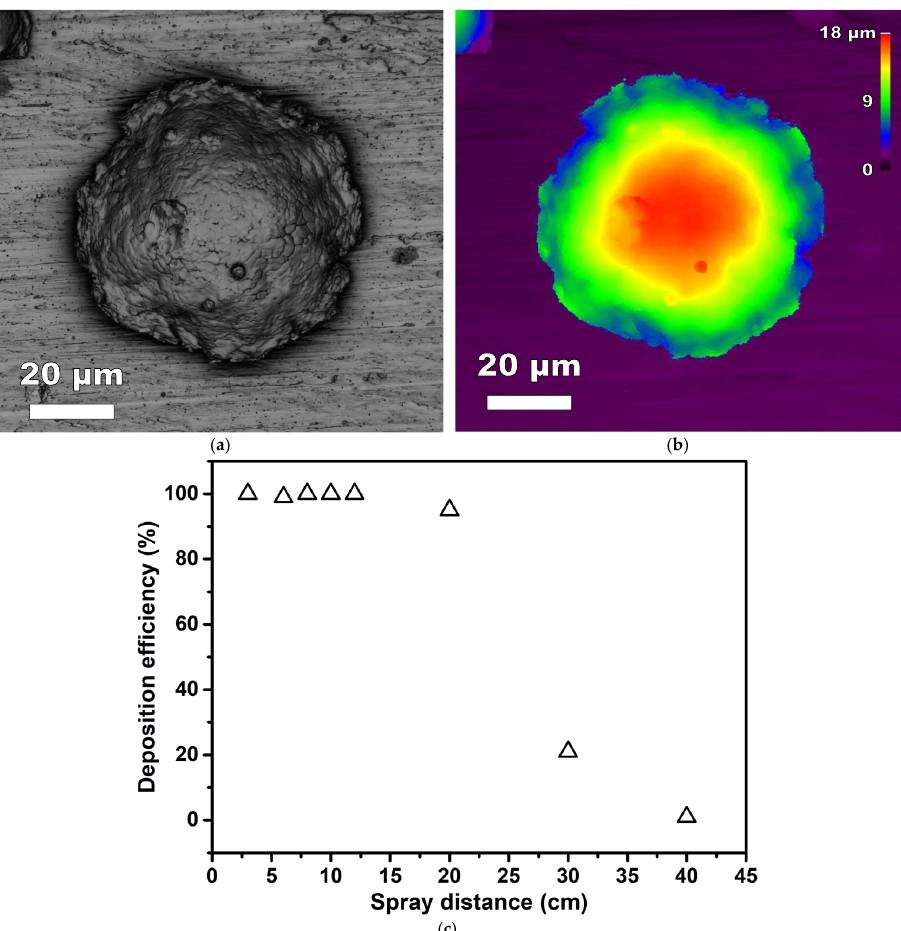
Figure 5. ( a ) Single Inconel 625 particle impact on Inconel 625 substrate at 20 cm standoff distance showing jetting around the circumference as confirmed by the ( b ) height profile image. ( c ) Deposition efficiency of Inconel 625 powder calculated using the KSS software.